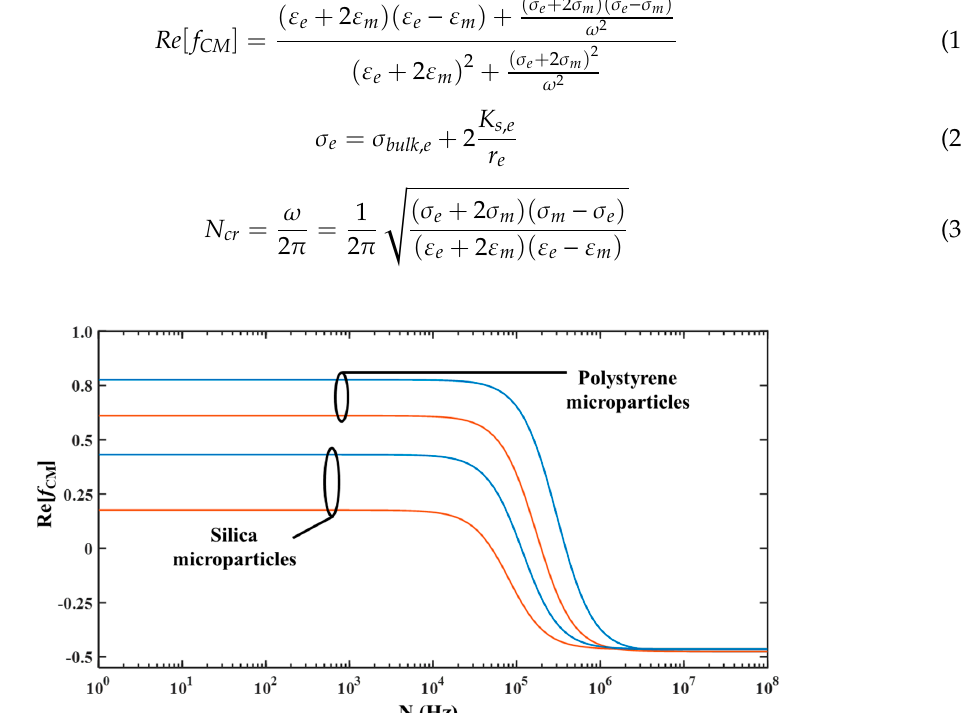
Figure 2. Variation of Re ( f CM ) with operating frequency for 2.5 μ m and 5 μ m microparticles ( ■ : 2.5 μ m, ■ 5 μ m and σ m = 0.0001 S/m).